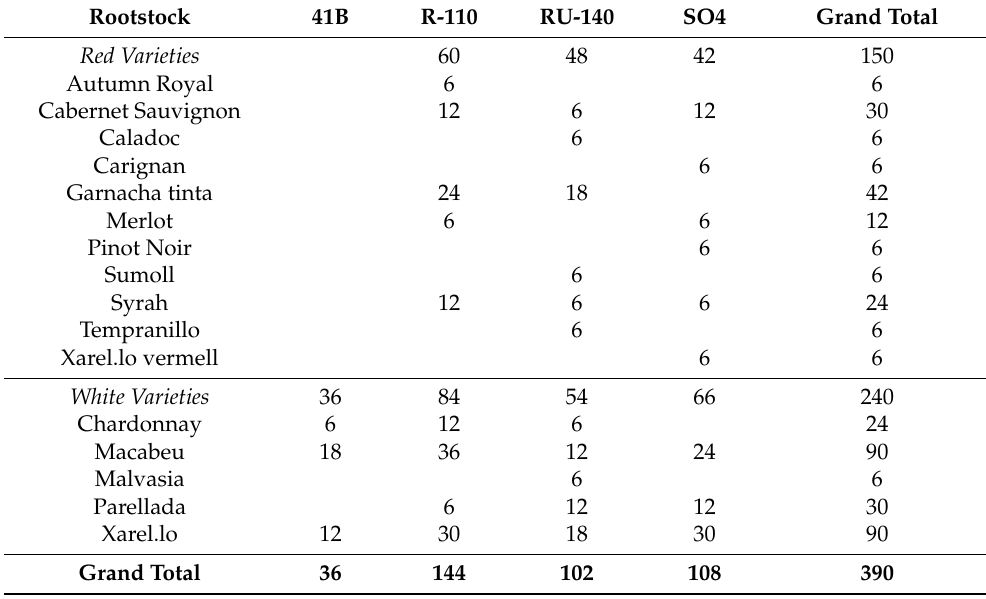
Table 1. Study design. Shown are the number of plants in each scion-rootstock combination. Grafted plants were taken from six different nurseries overall. At least three nurseries per color-rootstock combination were included in replicates of six (three plants each pre- and